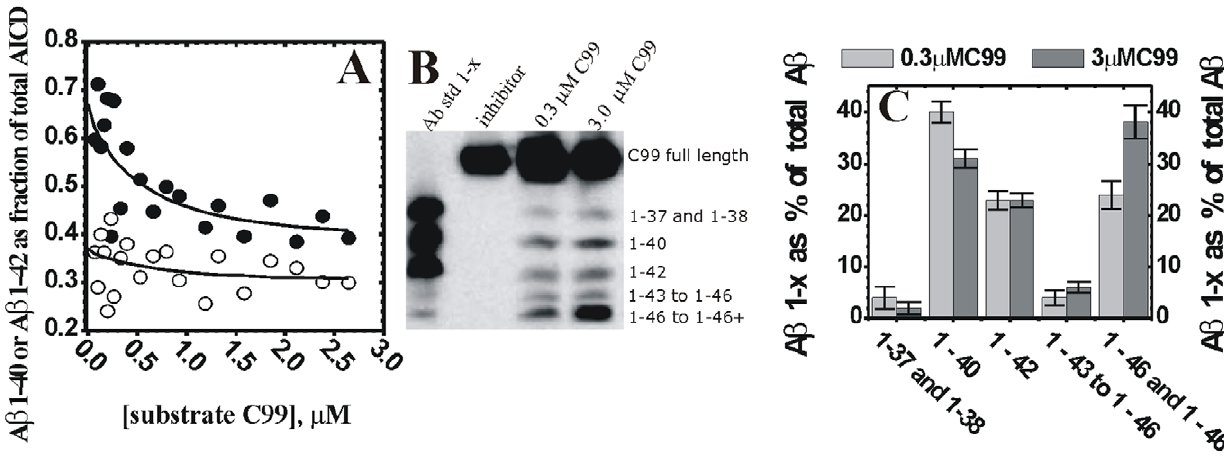
Figure 4. Changes in A b products caused by gradual saturation of c -secretase. Saturation of c -secretase with its C99 substrate leads to N decrease in A b 40 production with concomitant increase in production of the longer more hydrophobic A b peptides and A b 42/A b 40 ratio. (A) The ) and A b 1–42 (O) production and the total AICD production. The saturation profiles from Fig. 3 were used to calculate the ratio between A b 1–40 ( ratio curves were calculated using the saturation profiles from Fig. 3 in the absence of DAPT. (B) Urea gels were used to analyze the relative distribution of different A b 1-x fragments at half-saturating (0.3 m M) and saturating (3.0 m M) concentrations of C99 substrate. The lane ‘‘A b std 1-x’’ represents synthetic peptides as mobility standards, the lane ‘‘inhibitor’’ represents parallel control reaction in the presence of 10 m M of c -secretase inhibitors DAPT and LY-411,575 [3,4]. (C) The relative intensity of each A b 1-x peak is shown as a percent of the total sum of all A b peaks in the corresponding lane. The intensity of different A b 1-x products was quantified by transforming the individual bands into a series of peaks using the ‘‘ribbon option’’ in program ImmageQuant 5.0. The resulting peaks and the corresponding baselines were quantified using the ‘‘peak-fit’’ option in MicroCal Origin 7.0 program.